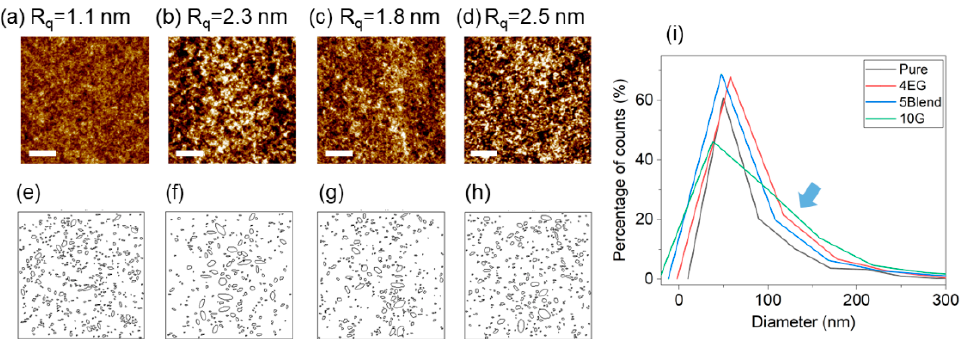
Figure 5. ( a – d ) AFM topographical images obtained in tapping mode with their corresponding roughness value: ( a ) pristine PEDOT:PSS, ( b ) PEDOT:PSS with 4 wt% EG, ( c ) PEDOT:PSS with 5 wt% (G+DMSO) and ( d ) PEDOT:PSS with 10 wt% G. ( e – h ) AFM height images after particle analysis processing. ( i ) Distribution of grain diameters analyzed by particle analysis plug-in of ImageJ software, version 1.53e.